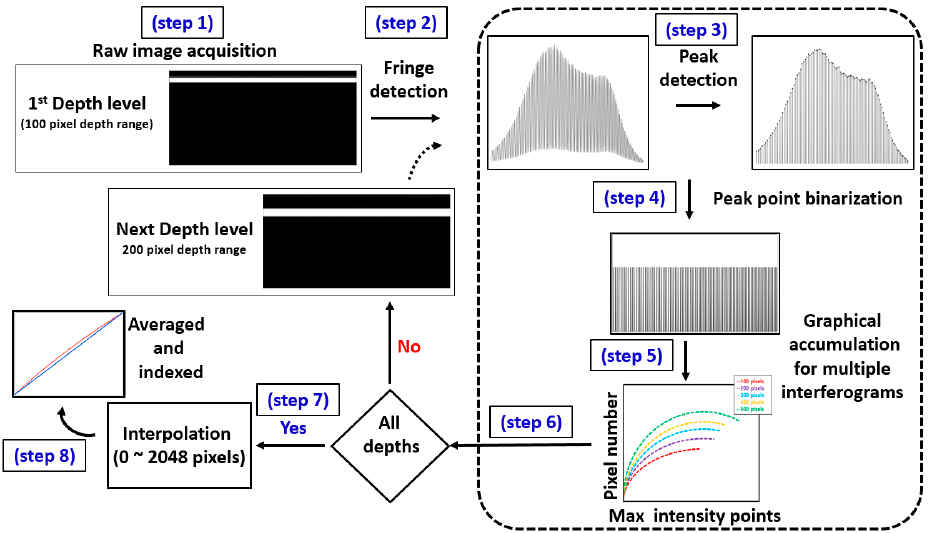
Figure 2. Graphical representation of the fundamental steps of the software-based intensity detection and resampling algorithm developed for the spectral calibration.